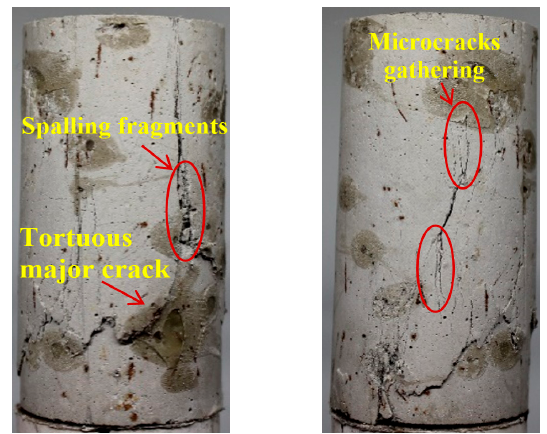
Figure 12. Crack pattern of Hy1 mixture after triaxial compression.